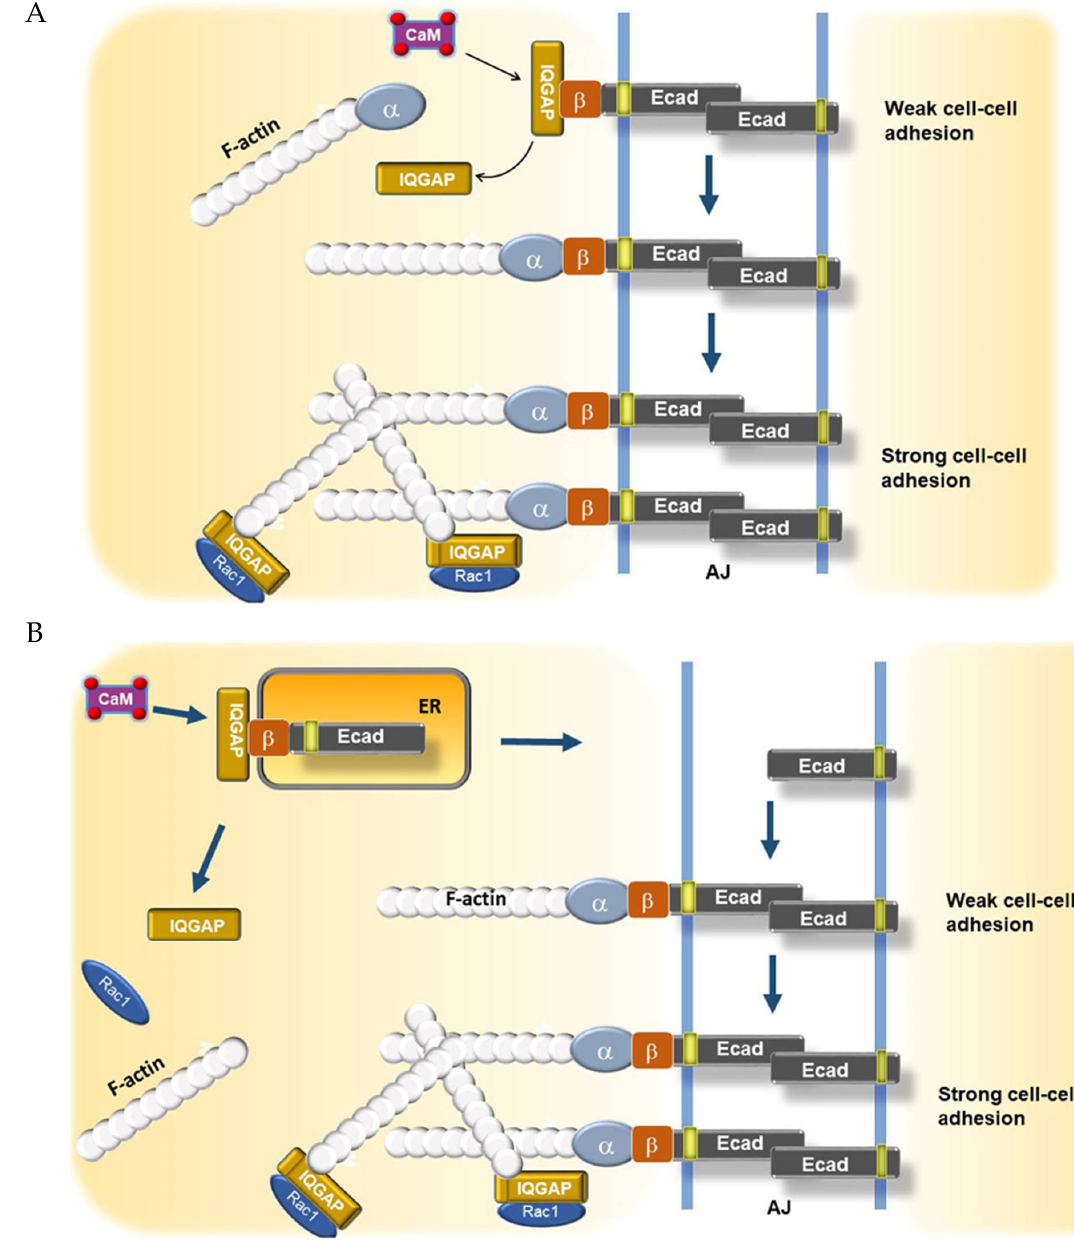
Figure 3. Two models for the role of Ca 2 + / CaM and IQGAP1 in adherens junction (AJ) formation and maturation. ( A ), IQGAP-bound Ecad-beta catenin can translocate to the cell–cell junction but form only a weak adhesion without displacement of IQGAP. Ca 2 + / CaM displaces IQGAP1 from beta catenin-E-cadherin, allowing association of an alpha catenin-bound actin microfilament with the nascent AJ. In the presence of activated GTP-bound Rac1 or CDC42, IQGAP promotes formation of an actin meshwork, leading to strong anchoring and cell–cell adhesion. ( B ), the IQGAP1-beta catenin-E-cadherin complex is retained in the ER until Ca 2 + / CaM displaces IQGAP1 at the ER membrane, allowing vesicle transport from the ER-Golgi to the junctional plasma membrane, immediately followed by the association of an alpha catenin-bound actin microfilament with the nascent AJ. Beta, beta catenin; alpha, alpha catenin; Ecad, E-cadherin. Red dots, calcium. For simplicity, Ecad is represented as a monomer. Based on work of Li, Noritake, Suisse, and co-workers [86,91,94,96].